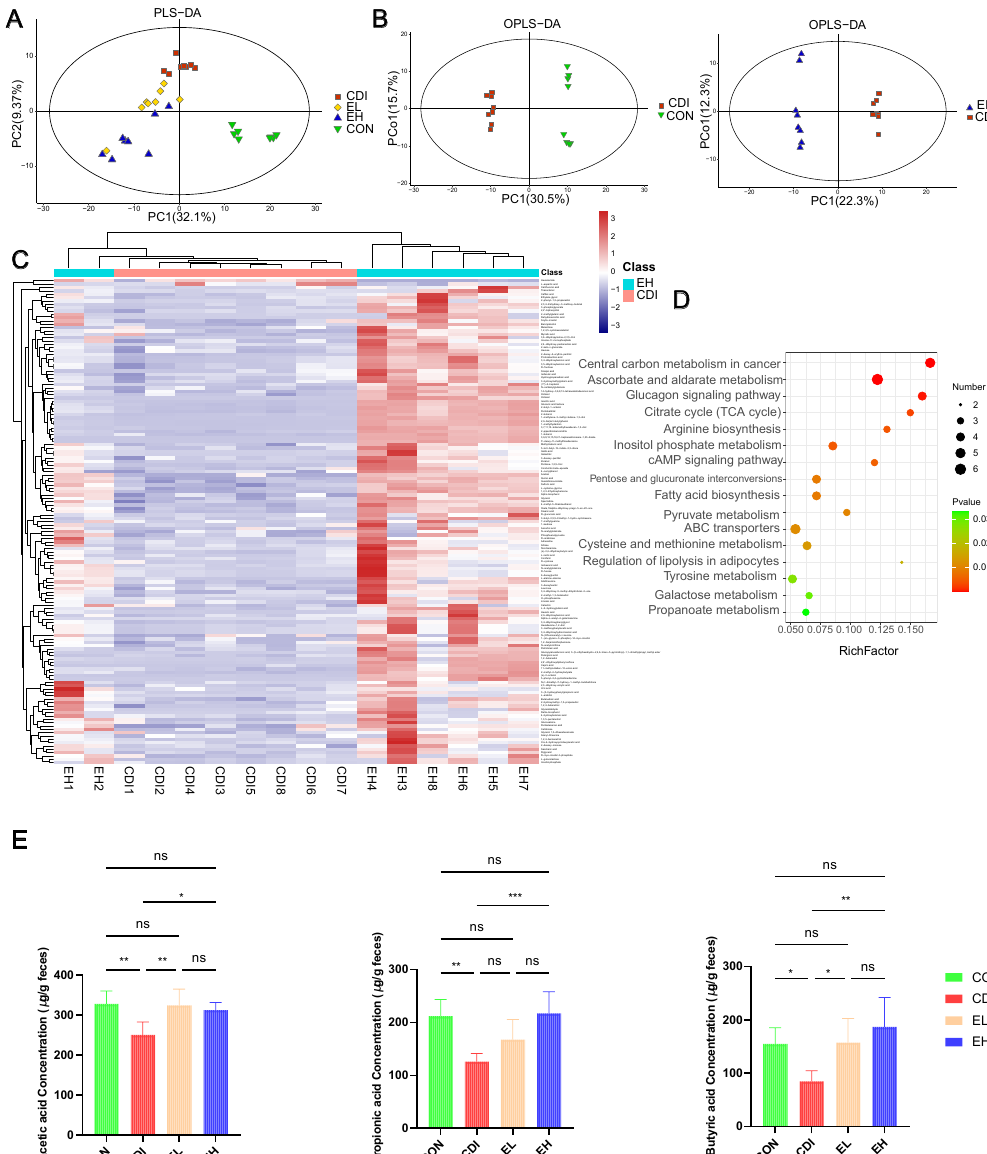
Figure 5. Modulation of metabolic disorders by EGCG after C. difficile infection. ( A ) PLS-DA showing the metabolic compositions of the CON, CDI, EL, and EH groups. ( B ) OPLS-DA plot showing the CON and CDI, CDI, and EH groups. ( C ) A hierarchical clustering heatmap of normalized (Z-score) levels visualizing significantly altered metabolites between the CDI and EH groups. ( D ) Differential KEGG metabolic pathways based on altered metabolites between the CDI and EH groups. ( E ) The levels of SCFAs between different groups. *, p < 0.05; **, p < 0.01; ***, p < 0.001; ns, p >